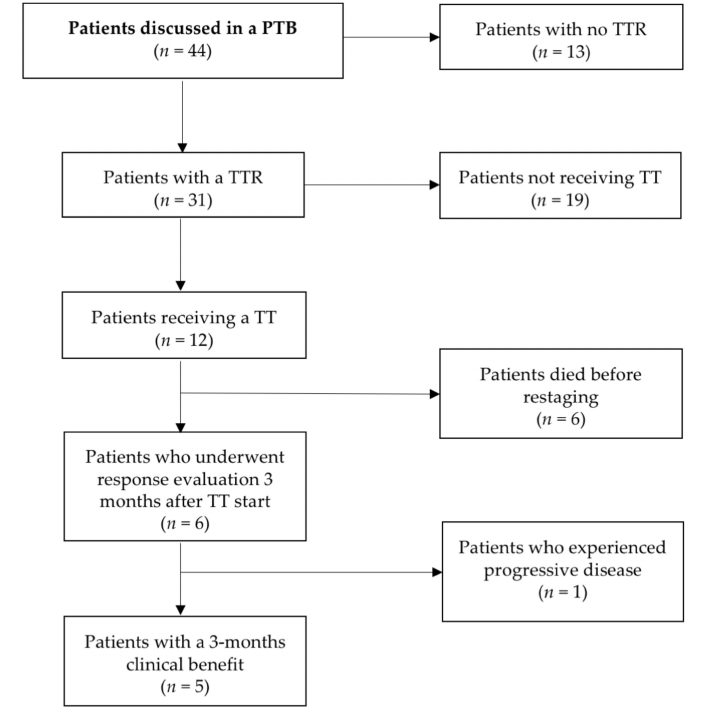
Figure 3. Patient